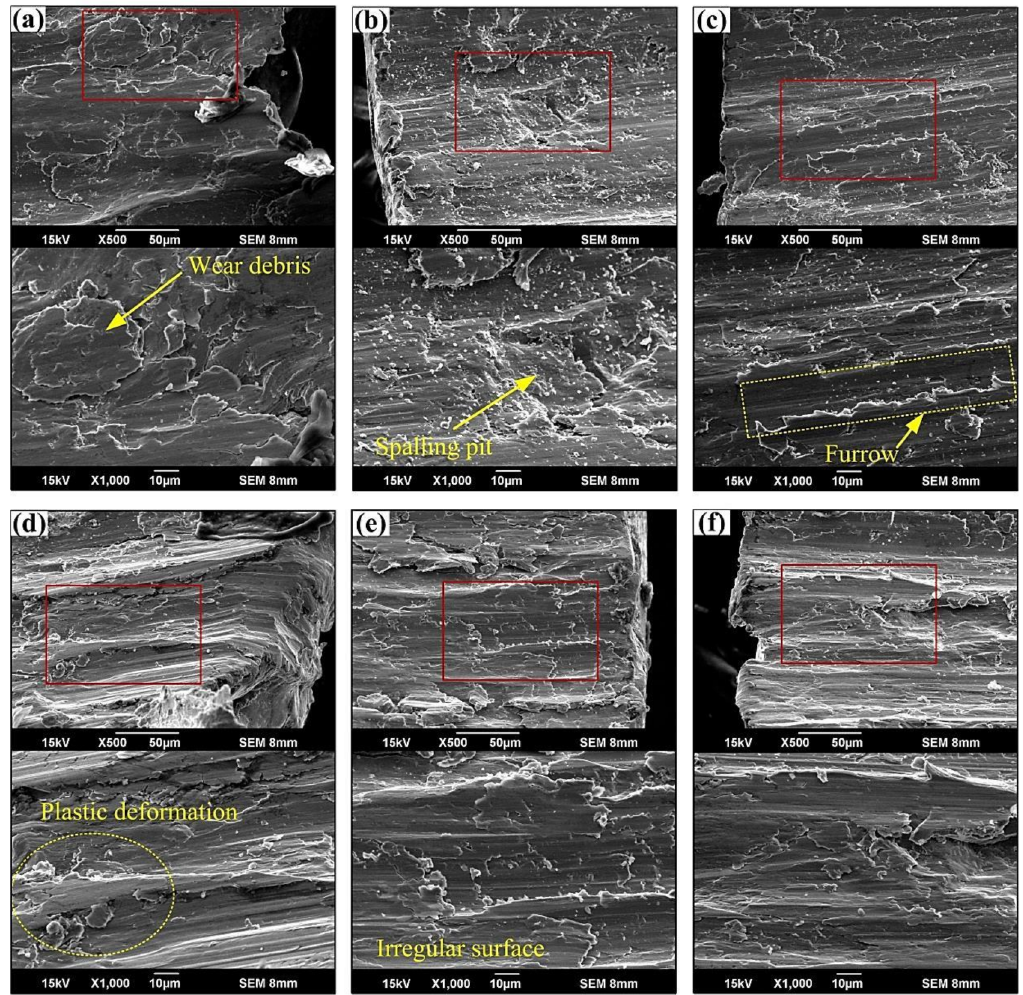
Figure 13. SEM micrographs of the wear surfaces with different morphology properties. ( a – c ) Relatively regular surface; ( d – f ) irregular